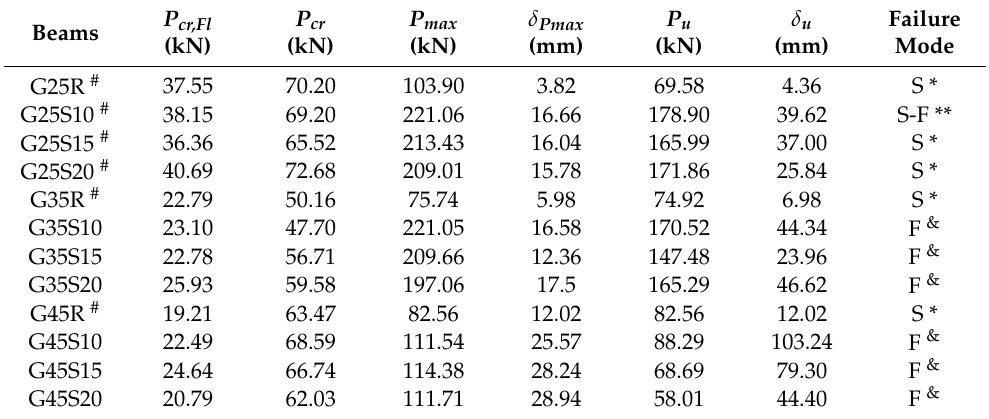
Table 3. Critical loads and deflections of